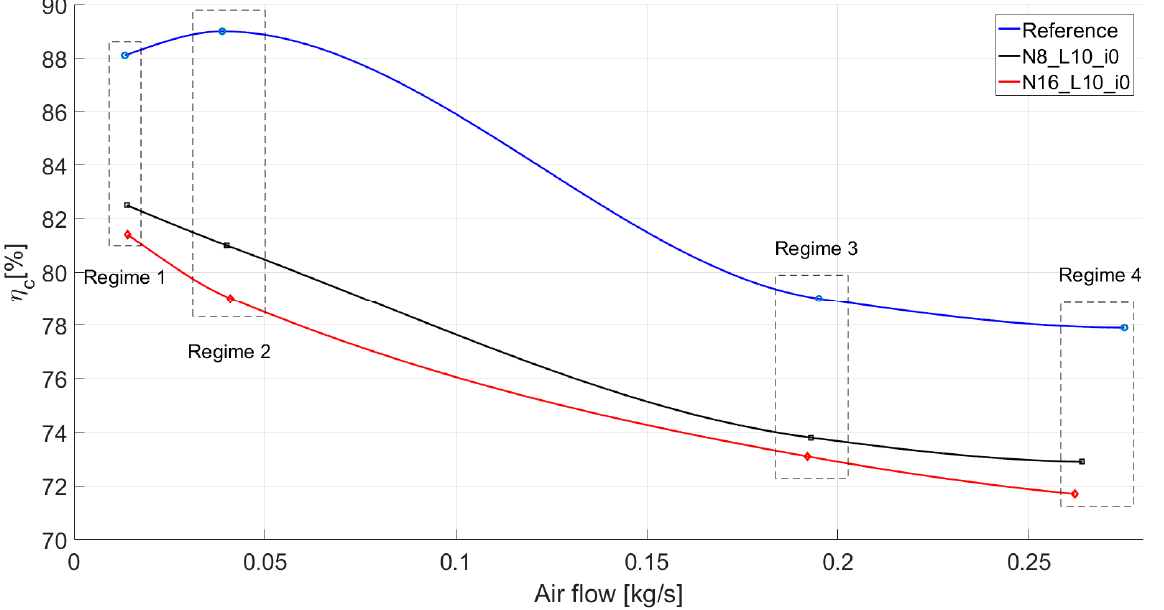
Figure 12. Compressor efficiency characteristic depending on the air flow.